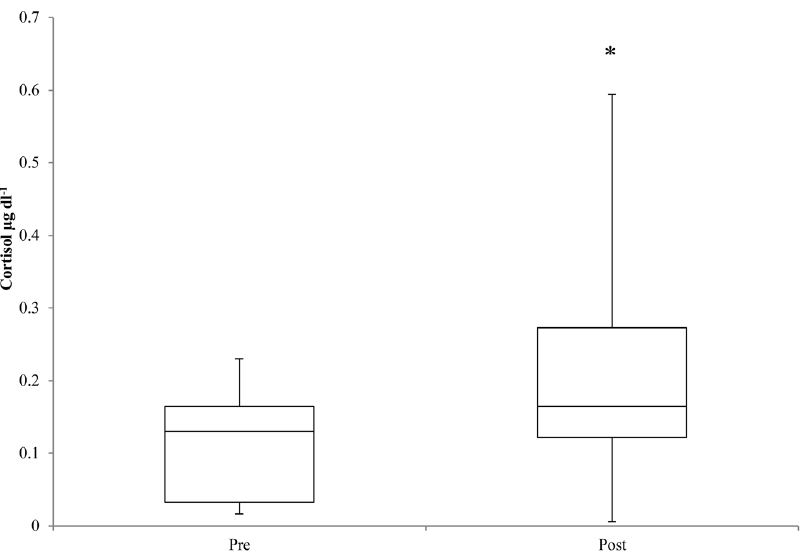
Figure 9. Cortisol concentrations in blow samples collected ‘pre’ and ‘post’ examination for Bristol Bay belugas. A significant increase in blow cortisol was detected, and is indicated by an asterisk (*) (p ,